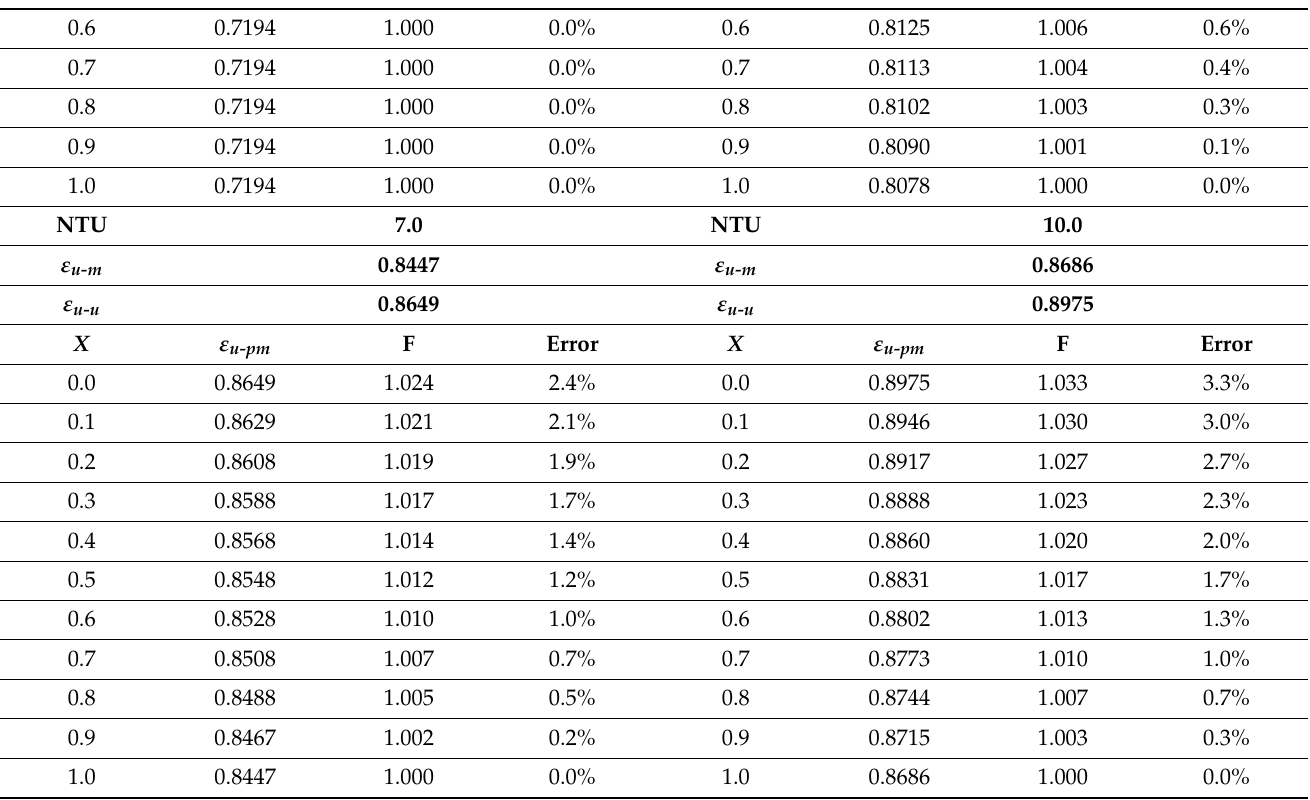
Table A3. Effectiveness correction factor “F” and Error in effectiveness estimation—3-row pure cross flow heat